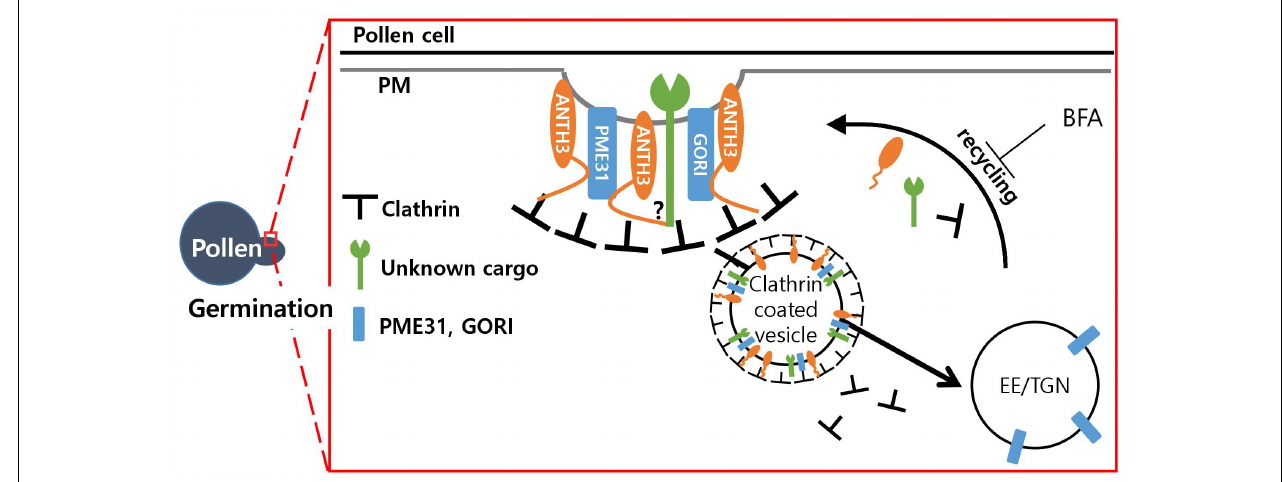
FIGURE 7 | Model of the possible role of Oryza satvia AP180 N-terminal homology domain-containing protein 3 (OsANTH3) in clathrin-mediated endocytosis in germinating pollen. OsANTH3 might function as an adaptor for clathrin-mediated endocytosis, which is critical for rice pollen germination. Unknown cargo and/or GORI and PME31 proteins might be endocytosed from the plasma membrane (PM) to the early endosome/trans-Golgi network (EE/TGN) by interacting with the N-terminal of the OsANTH3 protein. Brefeldin A (BFA) treatment inhibits recycling from the EE/TGN to the PM, and OsANTH3 can be formed as BFA bodies in the